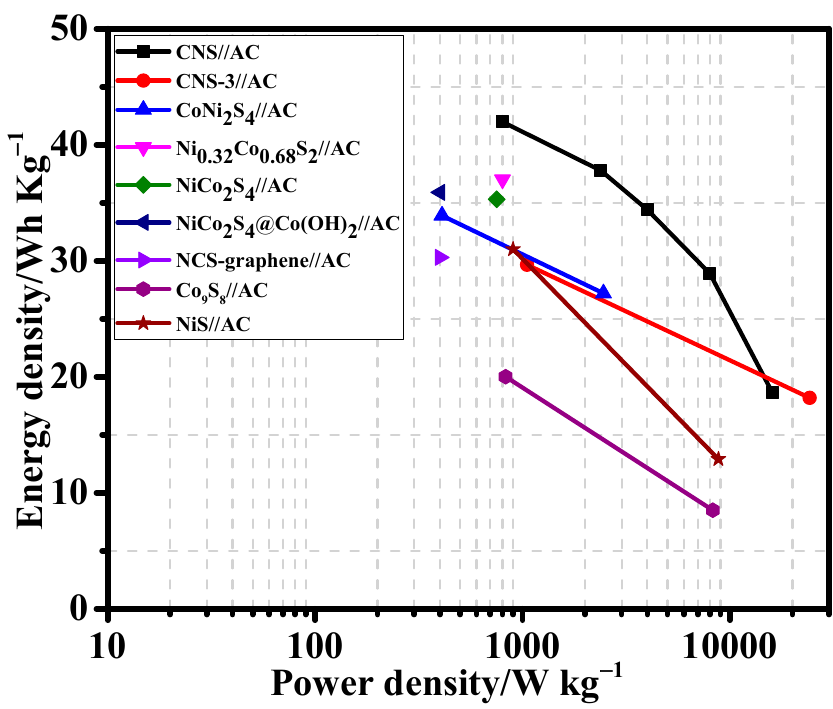
Figure 10. Ragone plot of energy density and power density of CNS//AC HSC device with previously reported supercapacitor devices.